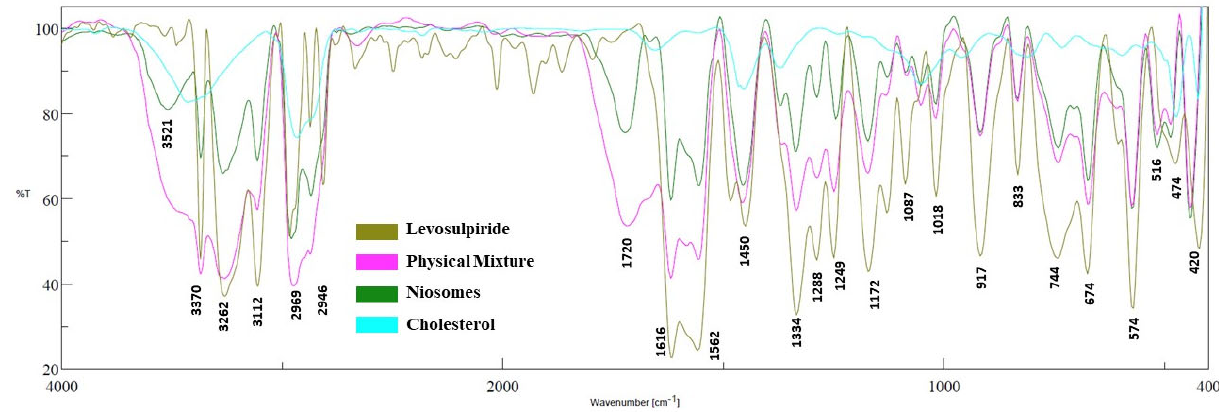
Figure 6. FTIR spectra of levosulpiride, physical mixture, cholesterol, and niosomes formulation.